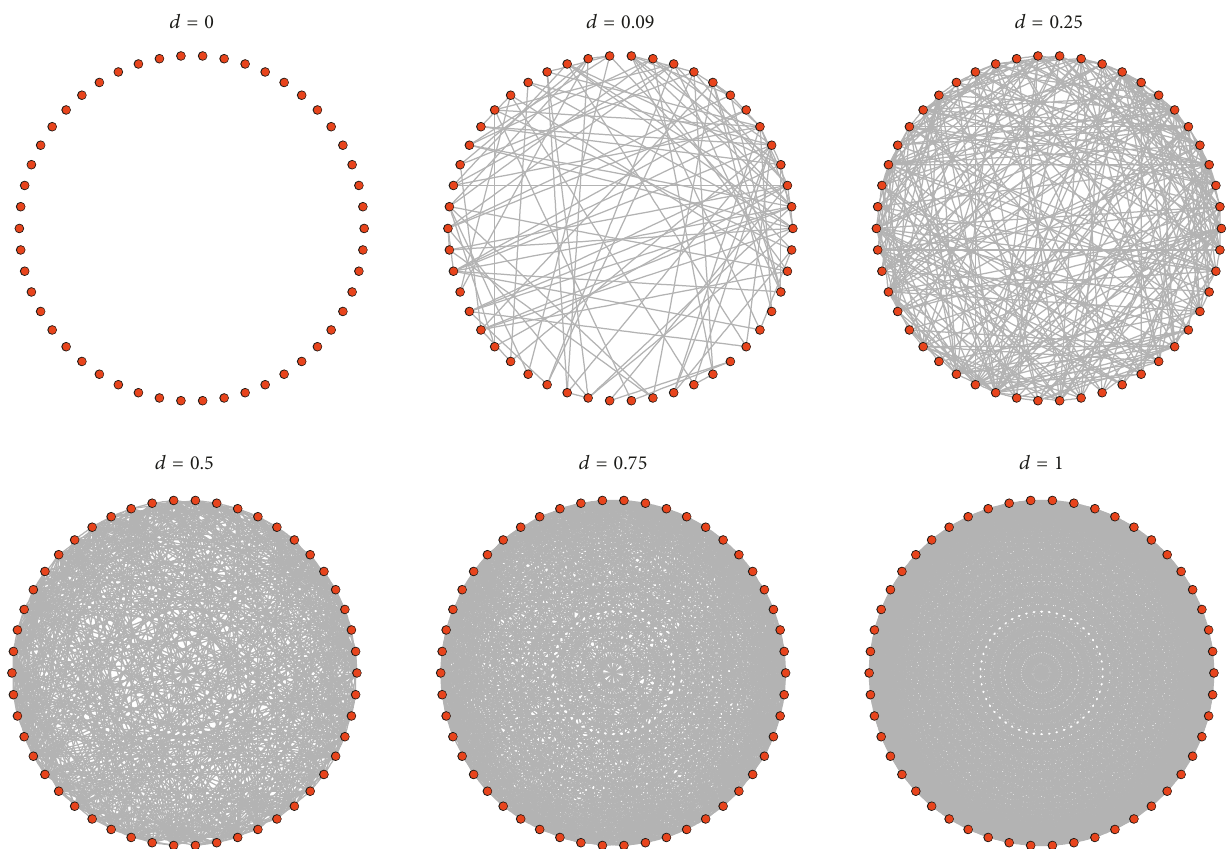
Table 1: Short glossary of metrics computed during simulations (note that 𝑑 𝑖𝑗 is the shortest path between nodes 𝑖 and 𝑗 in 𝐺 ). Measure Definition Formula Diameter ( 𝐷 ) Average path length (APL) Global clustering coefficient ( 𝐶 ) Global network efficiency ( 𝐸 )